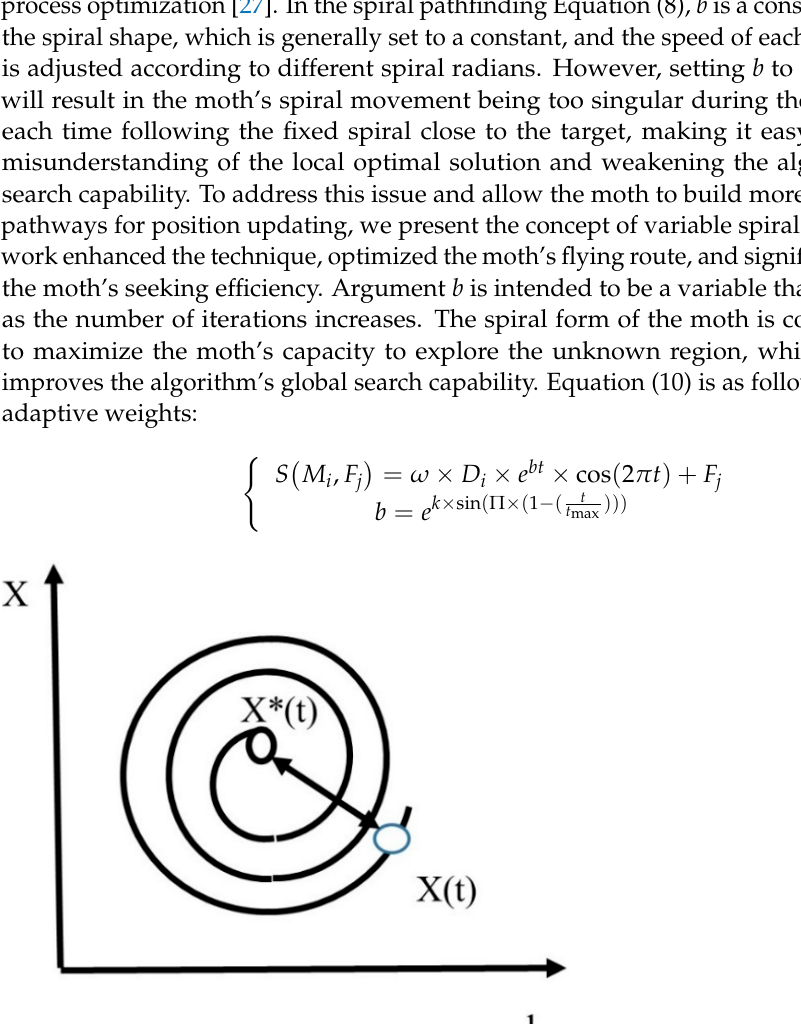
No Figure 3. An enhanced moth-flame optimization algorithm (IUVMFO).